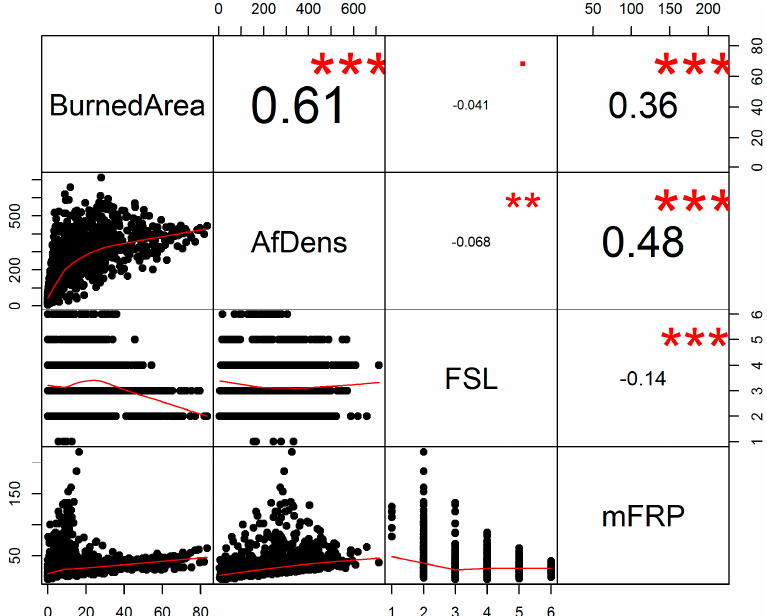
Figure 3. Bivariate relationships amongst the four fire-regime components, with Kendall non-parametric rank correlation coefficients indicating the direction and strength of correlations among each component pairs. Each variable’s name (Table 1) is shown on the diagonal. The lower triangle shows the bivariate scatter plots with a fitted smoothed line. The upper triangle shows the correlations and associated p -values: *** p <0.001, ** p < 0.05, ▪ p ≥ 0.05. Larger font sizes indicate stronger correlations. Table 2. Summary of fire regime characteristics (mean ± standard deviation) across ecoregions for the period 2003–2015.